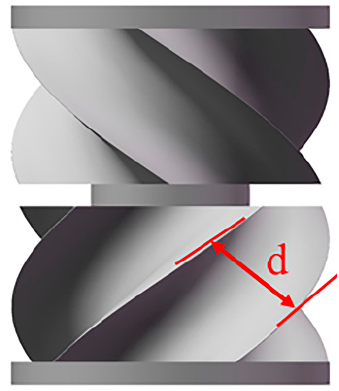
Figure 12. Diagram of normal distance between spiral groove openings.